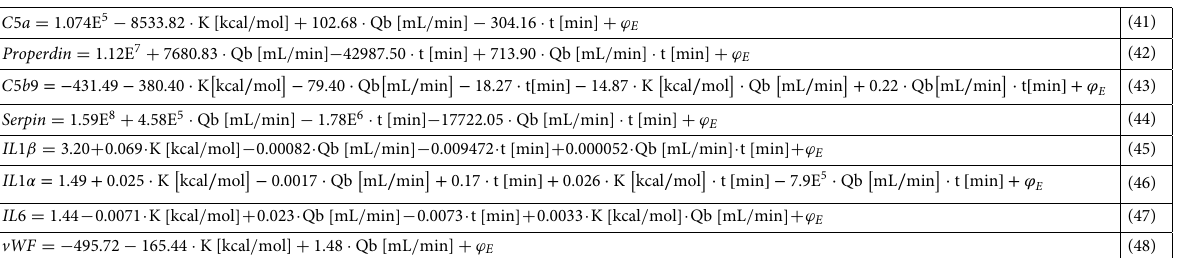
Box 6. Expanded model for blood flow rate and treatment time ranges for the concentrations of biomarkers as a function of membrane affinity to fibrinogen (K), Qb, and t.